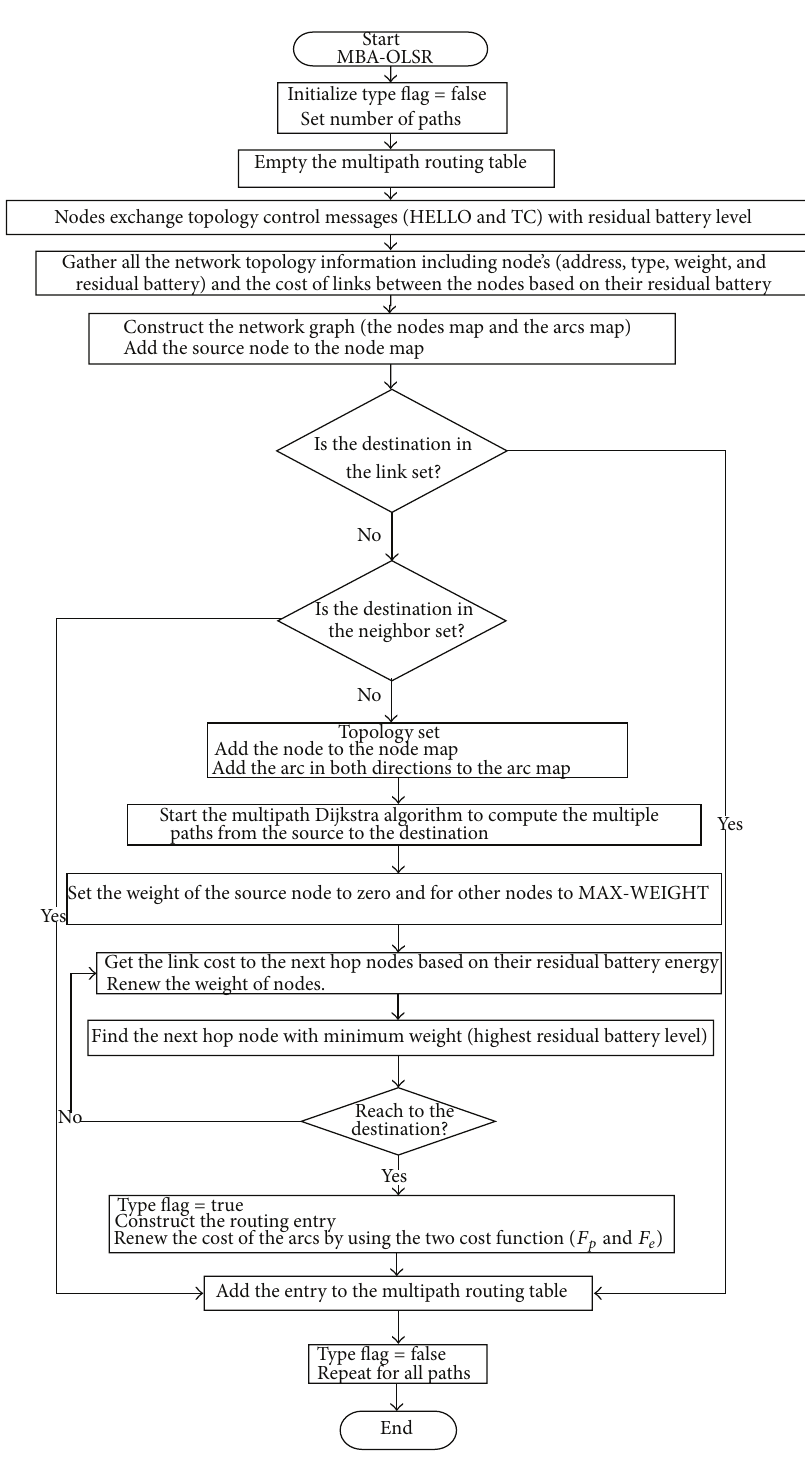
Figure 3: Flowchart for route computation in